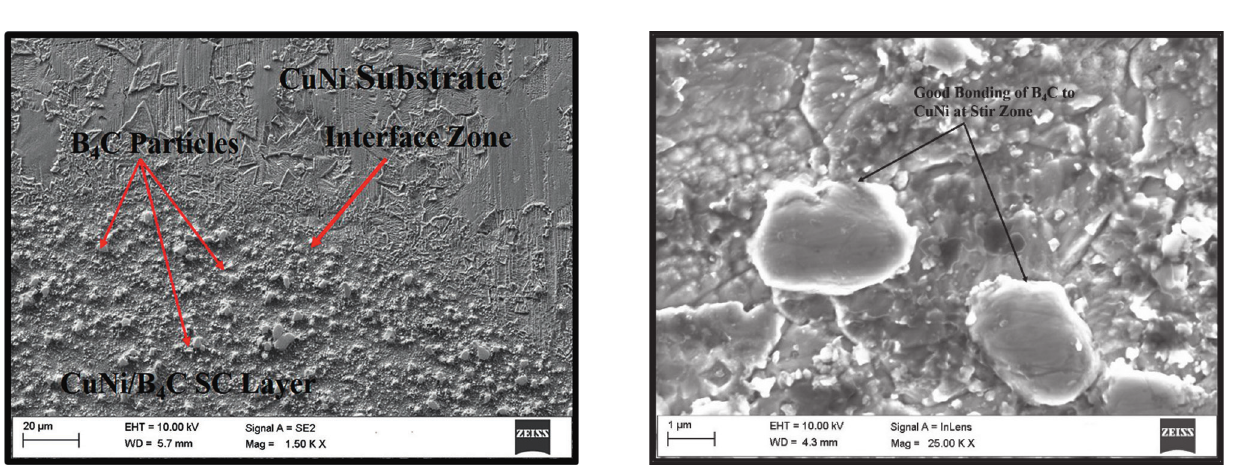
Figure 12: FESEM micrograph showing interface zone between CuNi alloy substrate and CuNi/B 4 C surface composite layer.